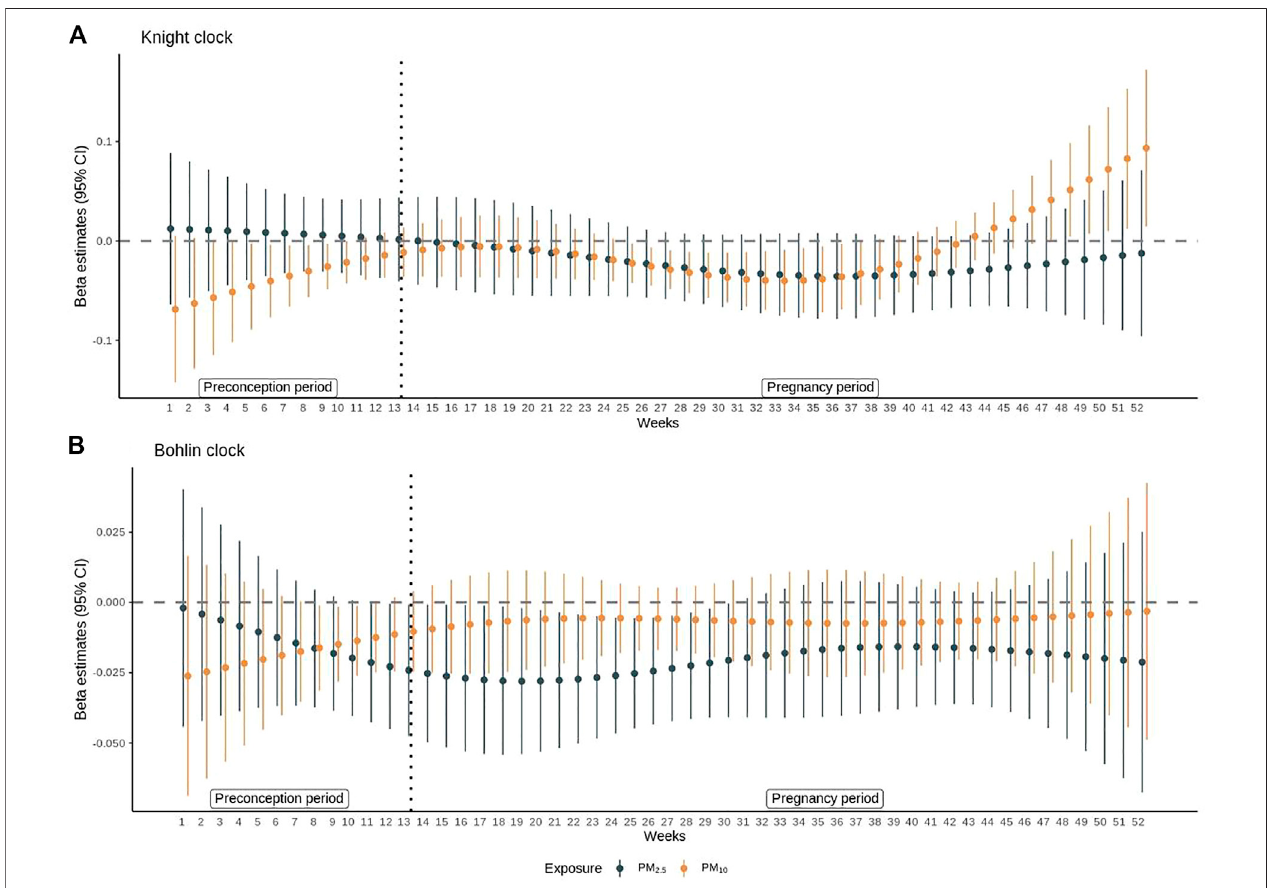
FIGURE 1 | Distributed lag model results for PM 2.5 and PM 10 . The β coef fi cients and 95% con fi dence intervals from distributed lag models (DLMs) are shown for associations between (A) PM 2.5 or PM 10 and epigenetic age acceleration estimated by Knight et al. (B) PM 2.5 or PM 10 and epigenetic age acceleration estimated by Bohlin et al. at each week of preconception (week 1 – 13) and pregnancy (week 14 – 52). All models were adjusted for child sex, maternal race/ethnicity, maternal education,yearofbirth,andregionoftheparticipantatrecruitment.The β coef fi cientrepresentsthedifferenceinepigeneticageaccelerationfora10-unitdifference in the pollutant. Epigenetic age acceleration was de fi ned as the residual of epigenetic age estimated by Knight clock or Bohlin clock on gestational age at birth adjusted for cell heterogeneity.